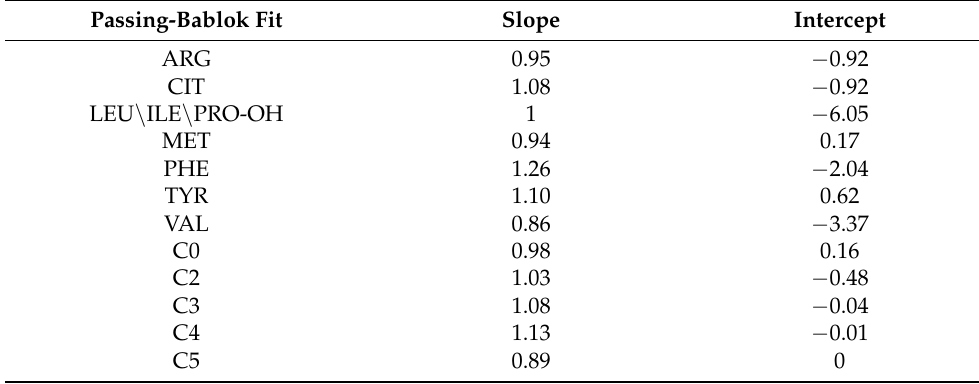
Table 5. Slope and intercept values of the regression curves for each analyte after method comparison between NeoBase™ 2 and MassChrom ® non-derivatized kits by Passing–Bablok. Passing-Bablok Fit Slope Intercept